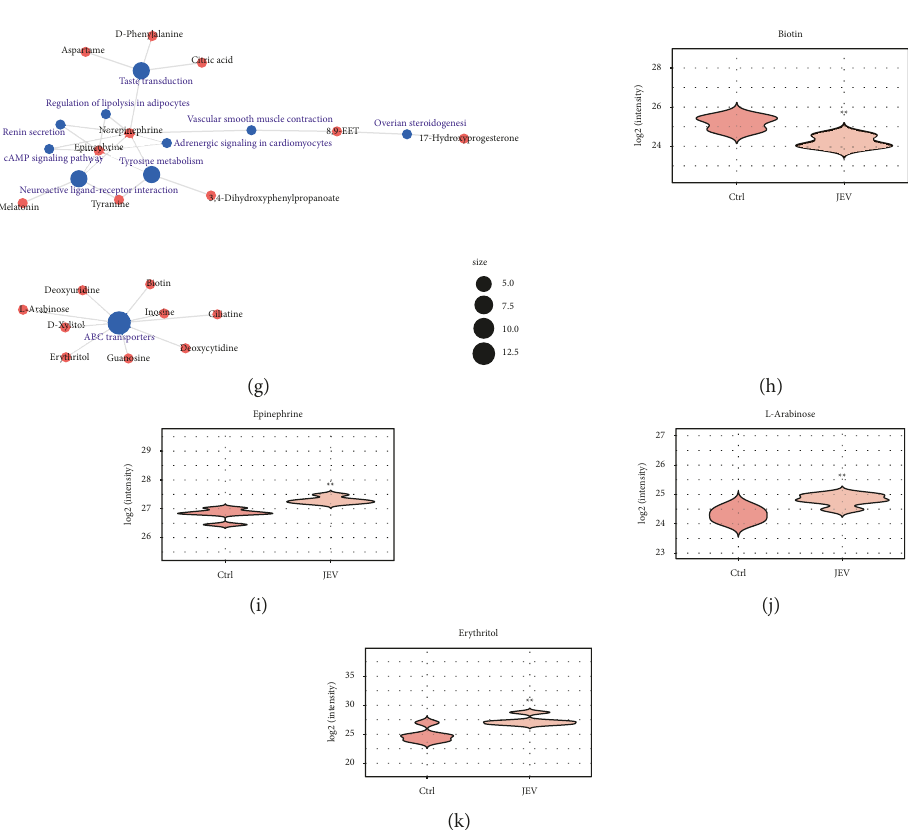
Figure 2: Urinary metabolite profiles reflect the characteristics of JEV infections. PCA in (a) the positive-ion mode and (b) the negative-ion mode. PLS regression in (c) the positive-ion mode and (d) the negative-ion mode. (e) Metabolite cluster heatmap of urine. (f), (g) A metabolomic view of pathway analysis to show the most obvious metabolic pathway affected by JEV infection. Violin diagram of (h–k) metabolites used to distinguish the JEV infection group from the control group. (h) Biotin, (i) epinephrine, (j) L-arabinose, and (k)